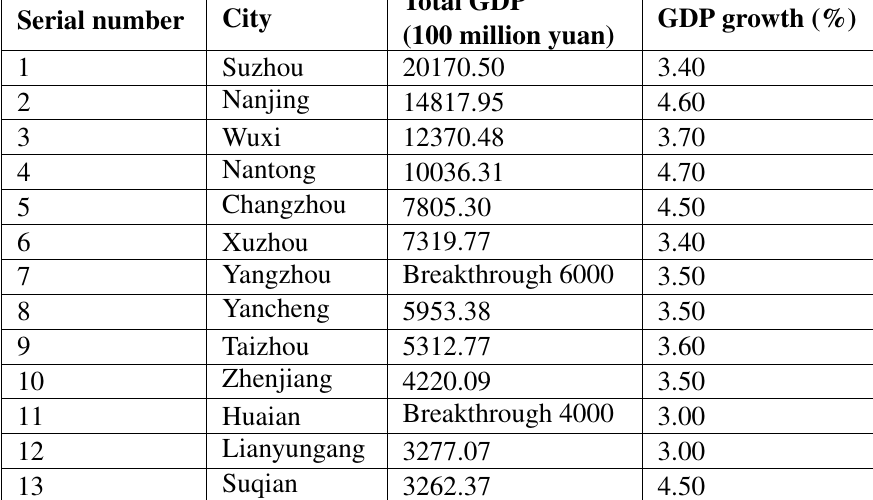
Table 1 GDP ranking results of 13 cities in Jiangsu Province in